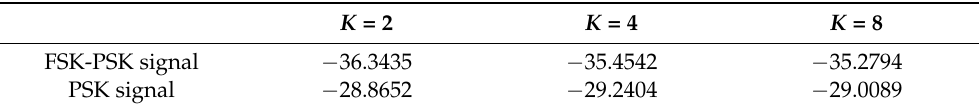
Figure 6. AISL comparison of the FSK-PSK signal and the PSK signal. ( a ) K = 2. ( b ) K = 4. ( c ) K = 8. Table 3. AISL comparison between FSK-PSK signal and PSK signal (unit: